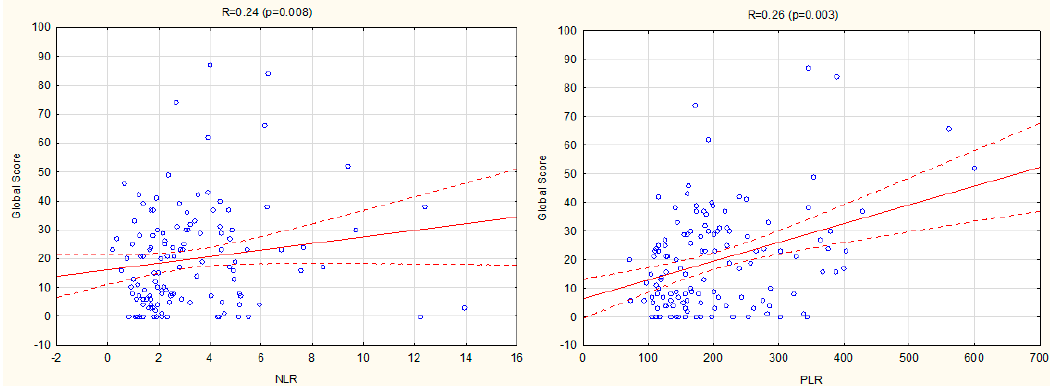
Figure 1. Correlations between NLR, PLR, and US scores (GSUS, PDUS, Global score) in RA patients. GSUS, Grey Scale Ultrasound; NLR, neutrophil–lymphocyte ratio; PDUS, Power Doppler ultrasound;